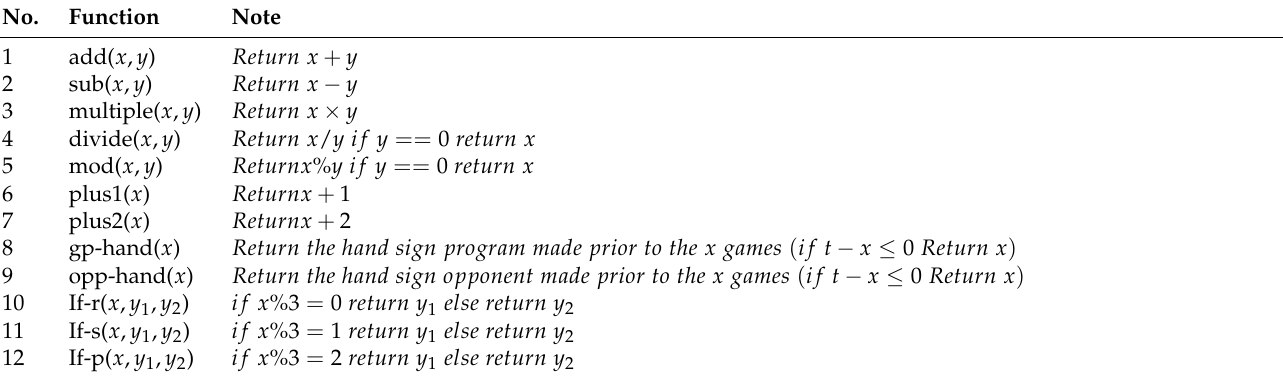
Table 1. Functions used to infer RPS